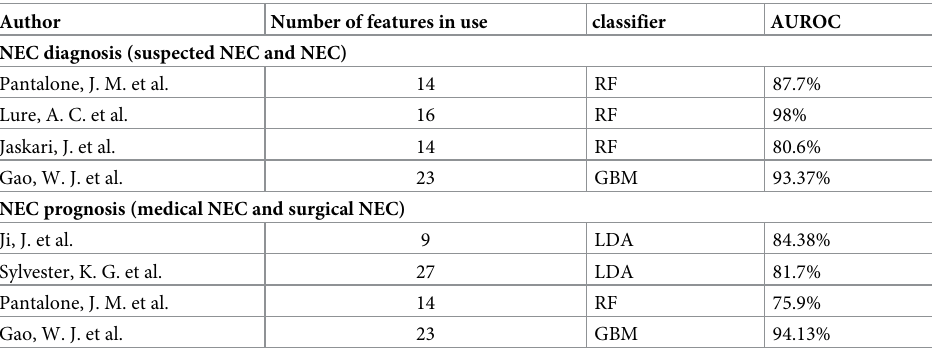
Table 1. Relevant studies involving ML methods for NEC diagnosis and